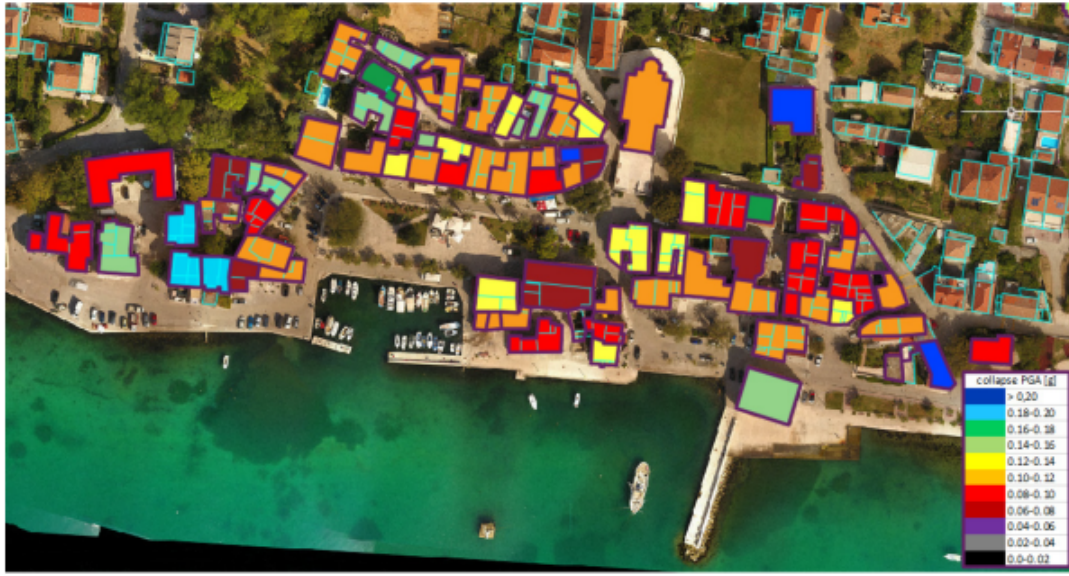
Figure 17. Map of collapse